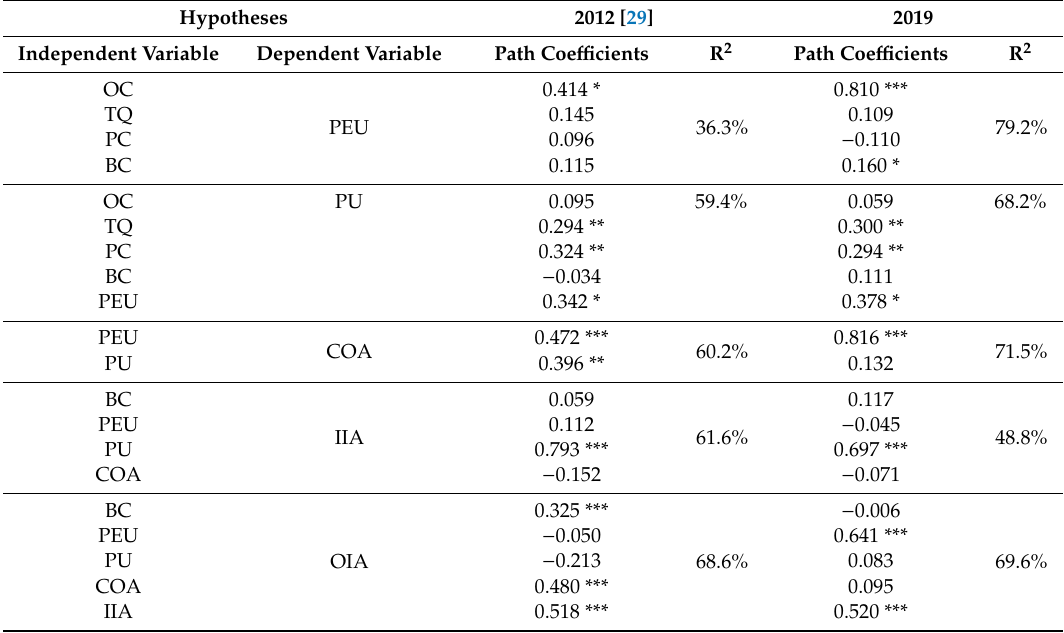
Table 8. Comparison between BIM acceptance Model (2012) and BIM acceptance Model (2019).